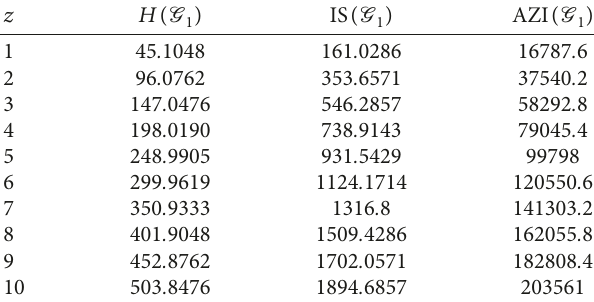
Table 9: Comparison among different TIs of (TM-TCNB) 1 .